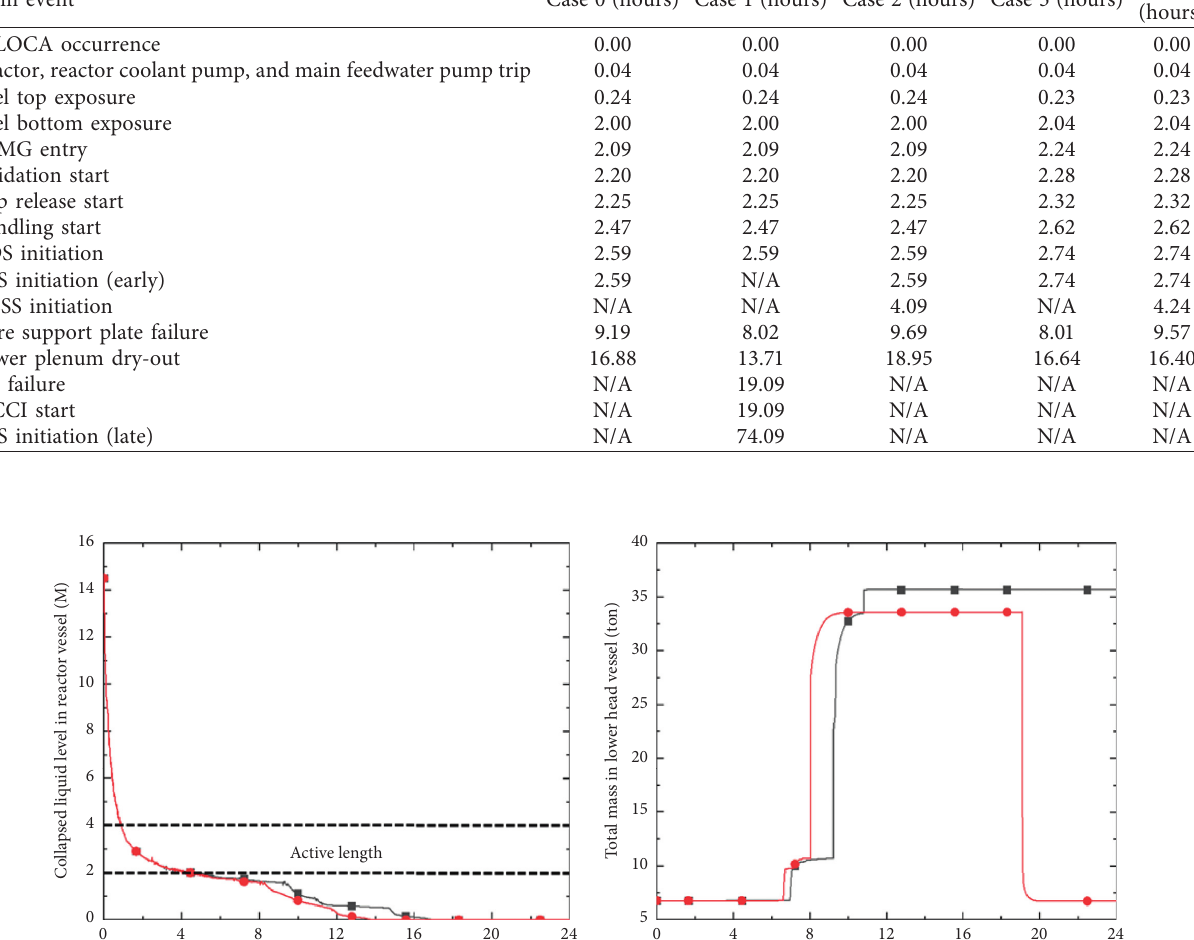
Table 3: Main event times from MELCOR analysis for the small break loss-of-coolant accident in the SMART. Main event